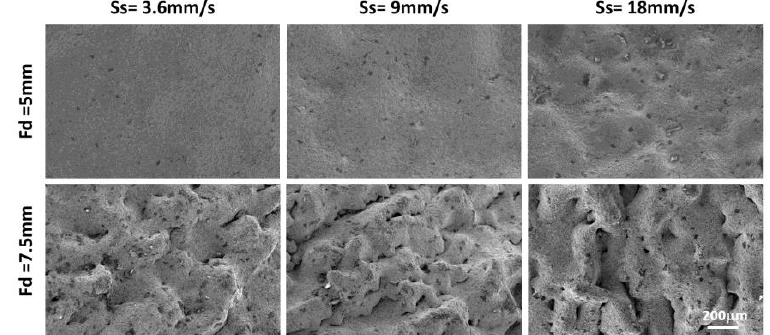
Figure 8. Scanning electron microscopy (SEM) images of the surface after laser polishing at different Ss and Fd.